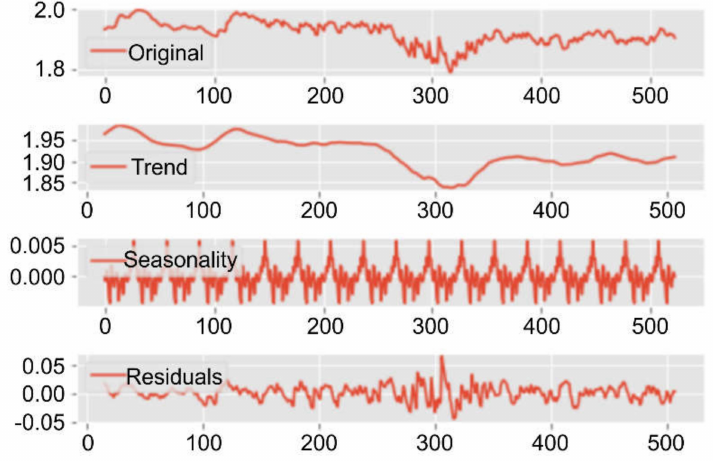
Figure 2. STL decomposition of